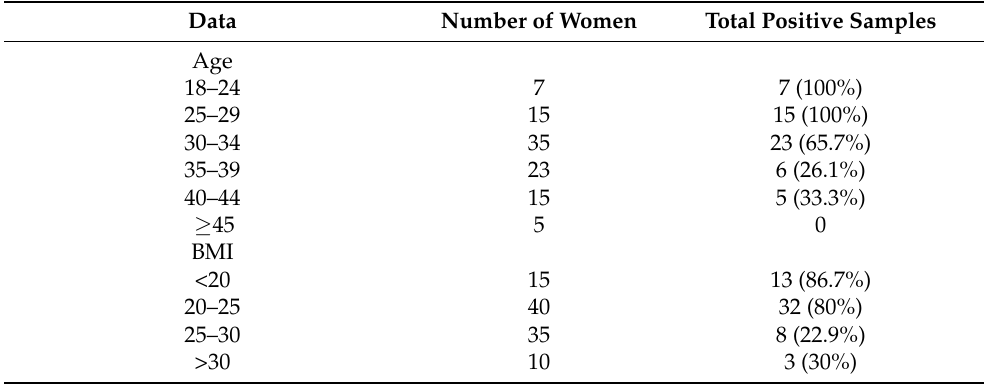
Table 4. Correlation of maternal demographics, anthropometric characteristics, and nutritional habits with positive samples in Bifidobacterium and/or Lactobacillus